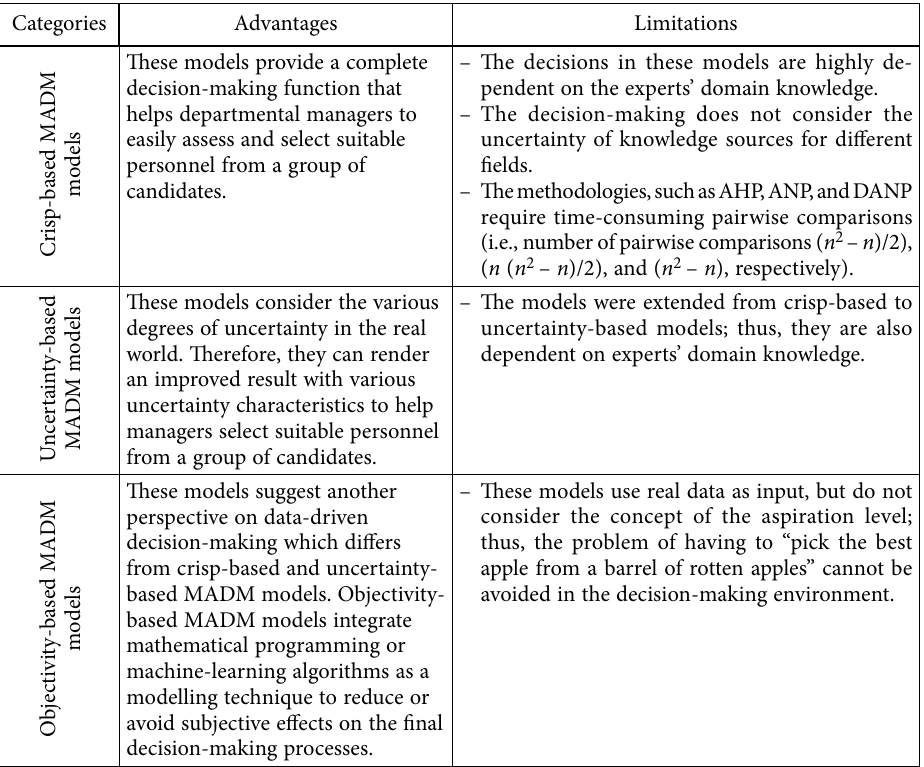
Table 1. Comparative analysis of various MADM models